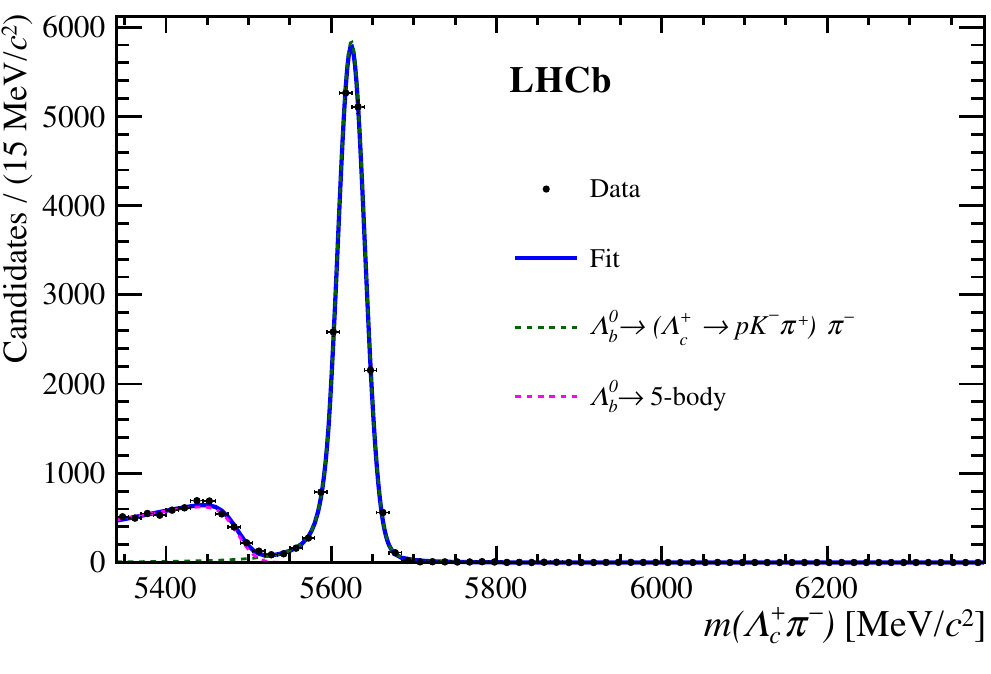
Figure 6 . Results of the (cid:12)t to the (cid:3) + (cid:25) (cid:0) candidate mass spectrum on linear scale. The di(cid:11)erent c components employed in the (cid:12)t are indicated in the